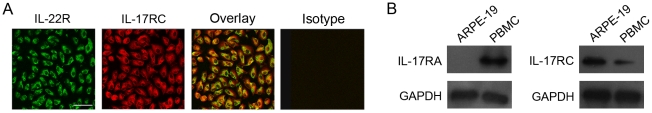
Expression of IL-22R and IL-17RC in ARPE-19 cells.(A) Coexpression of IL-22R and IL-17RC in ARPE-19 cells was shown by immunocytochemistry. Scale bar  = 75 µm. (B) Western blot revealed that ARPE-19 cells expressed only IL-17RC. However, PBMCs expressed both IL-17RA and IL-17RC.